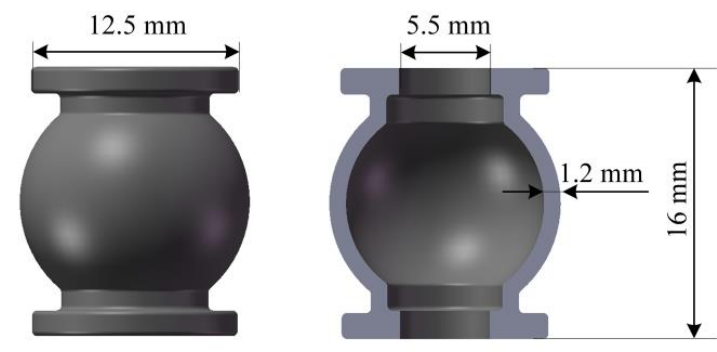
Figure 1. Schematic diagram of the rubber isolator’s structure.